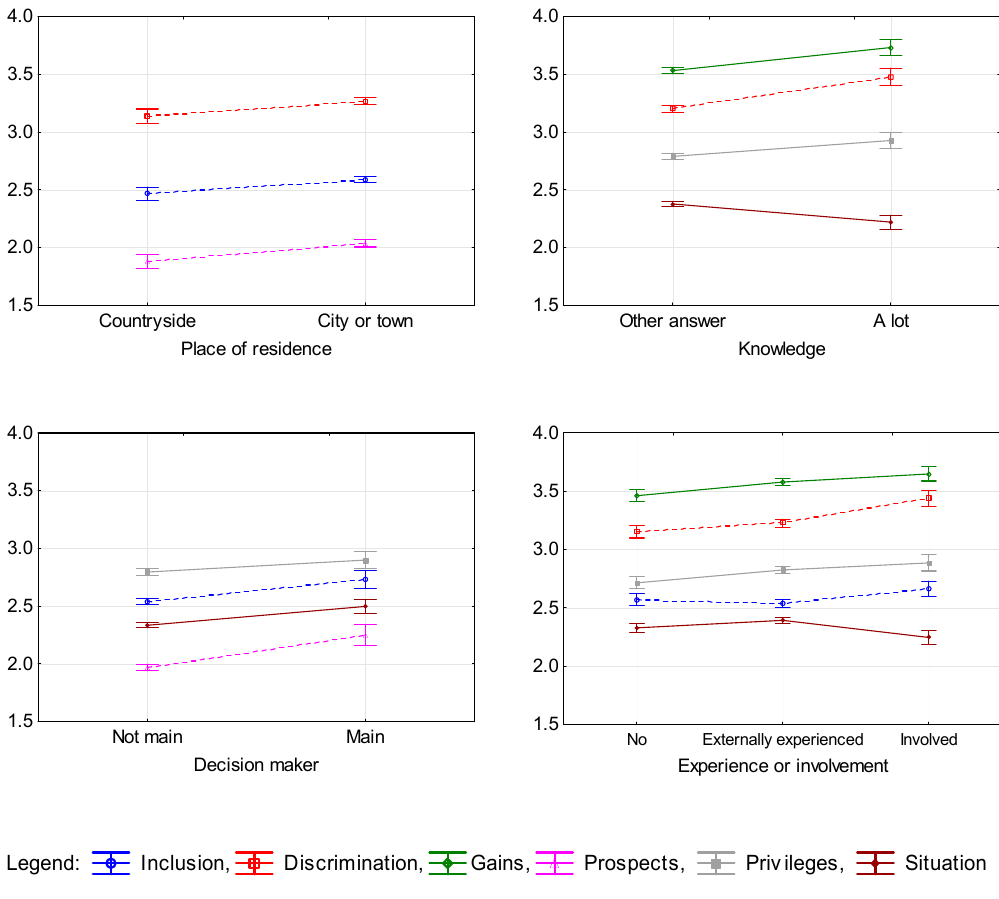
Figure 1. Graph of means of categorical variables with 95% confidence intervals.